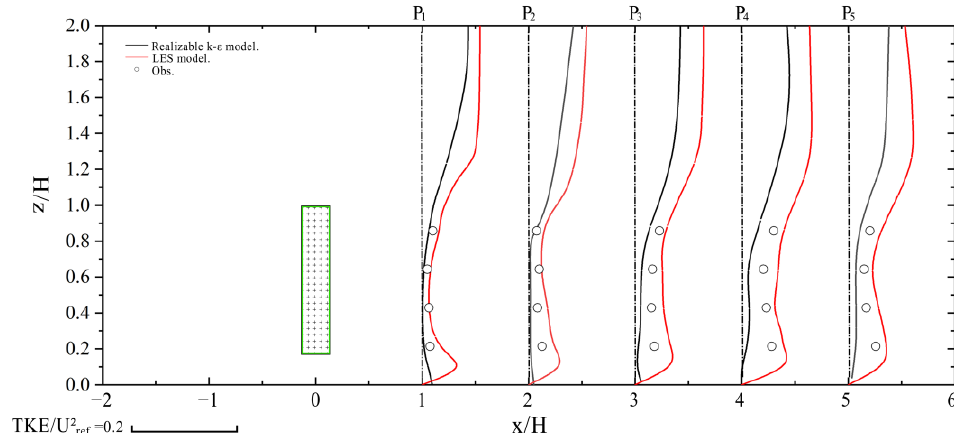
Figure 4. Comparison of simulated and measured profiles of turbulent kinetic energy behind the row of canopy. The green rectangular marks the canopy region occupied by trees.